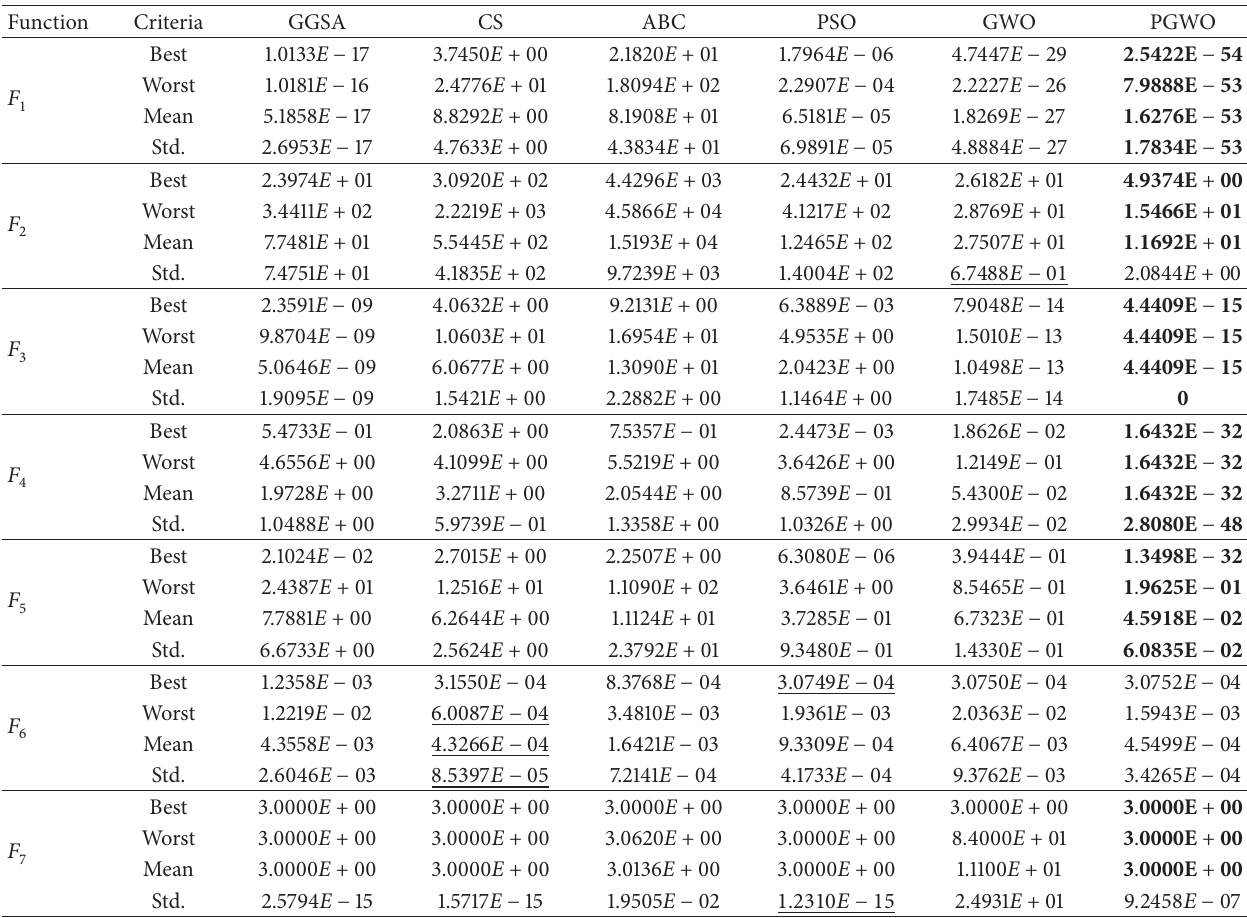
Table 3: Results comparison of different optimal algorithms for 20 independent runs.